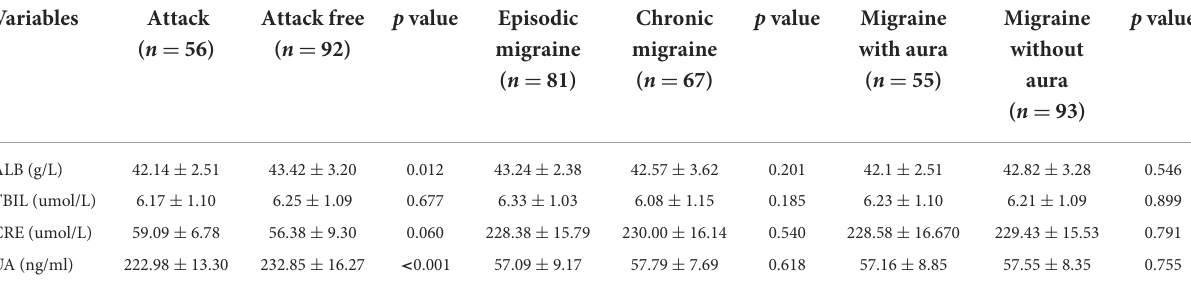
TABLE 2 Serum levels of UA, TBIL, ALB, and CRE in migraine subtypes. Variables